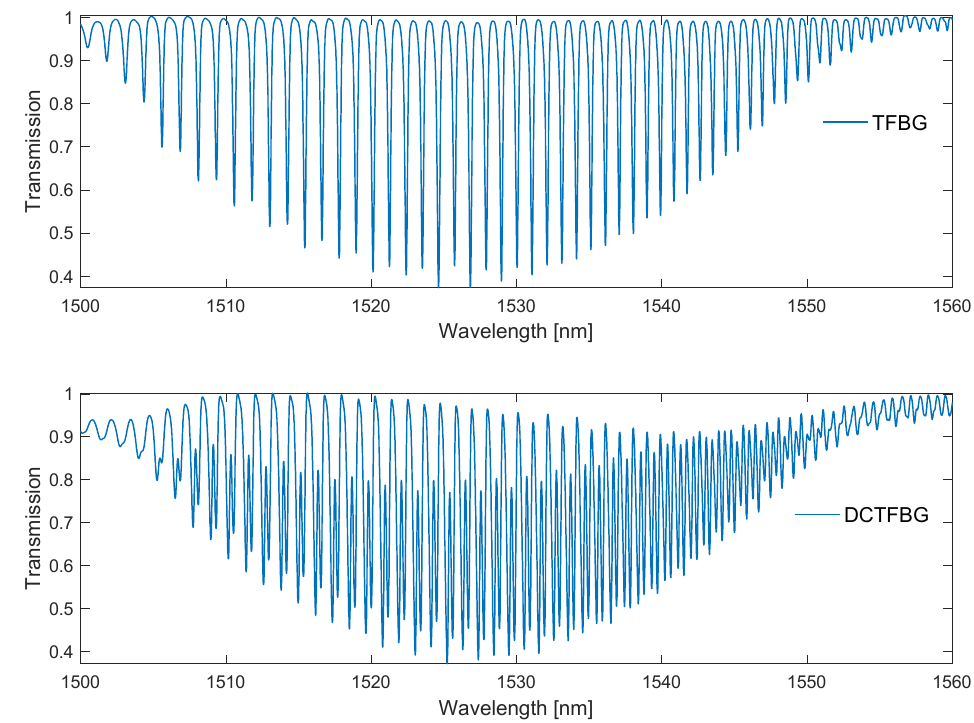
Figure 1. Spectrum of a TFBG and of a DC-TFBG, the latter being one of the gratings produced by us.